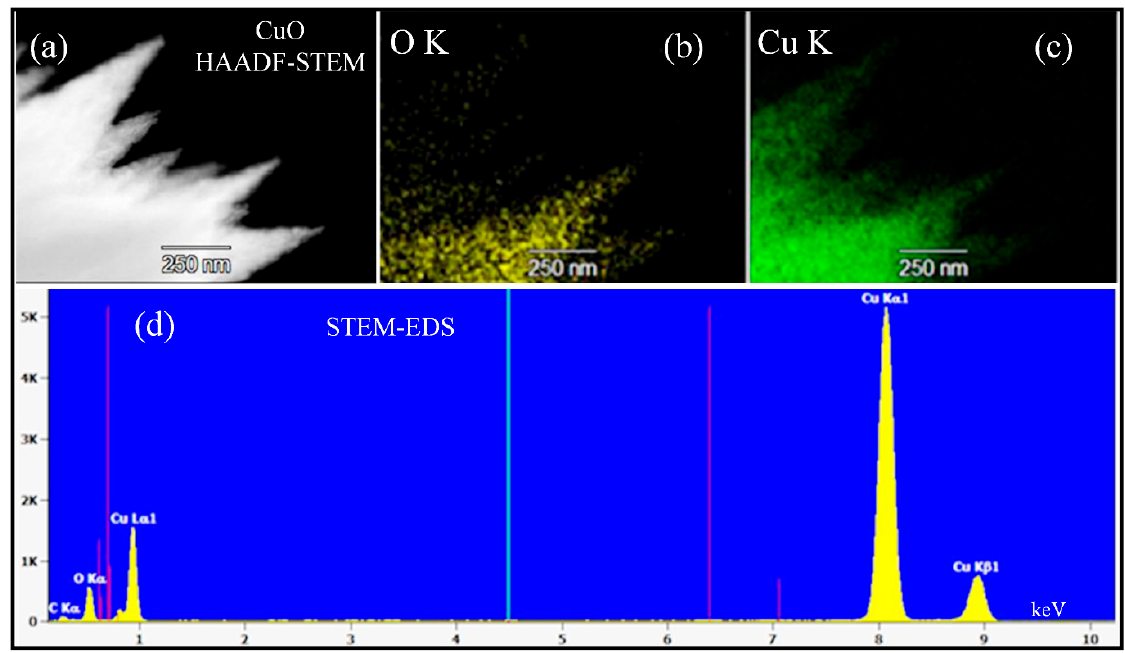
Figure 5. HAADF-STEM analysis of Single CuO Nanoflower. ( a ) HAADF-STEM image; ( b , c ) Chemical mapping of O and Cu, respectively; ( d ) STEM-EDS spectrum.